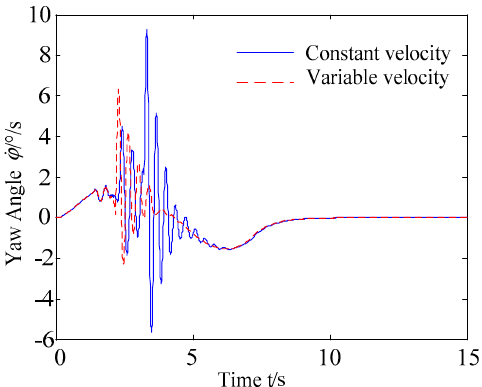
Figure 31. Yaw rate of vehicle p under different velocities of vehicle q .